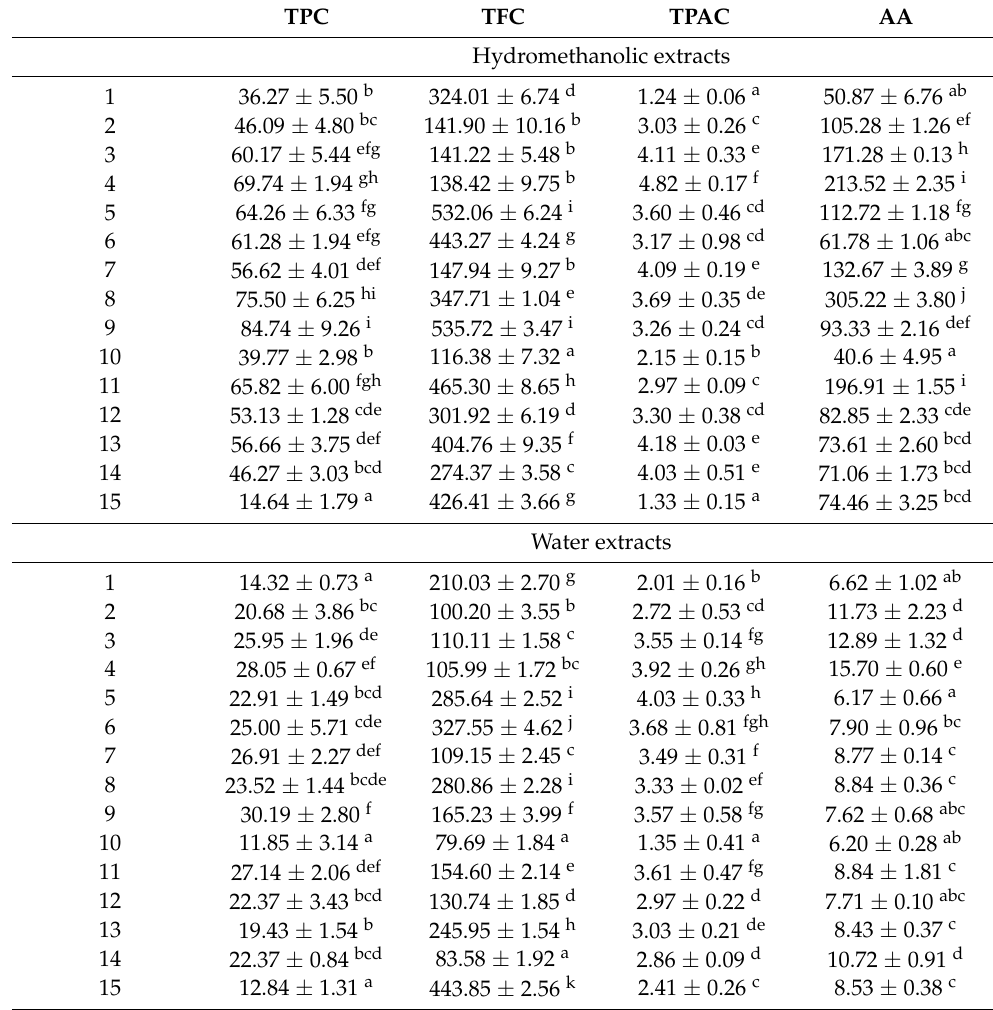
Table 2. The quantitative results of total phenolics (TPC), flavonoids (TFC), phenolic acids (TPAC), and L(+)-ascorbic acid (AA) in R. rosea commercial